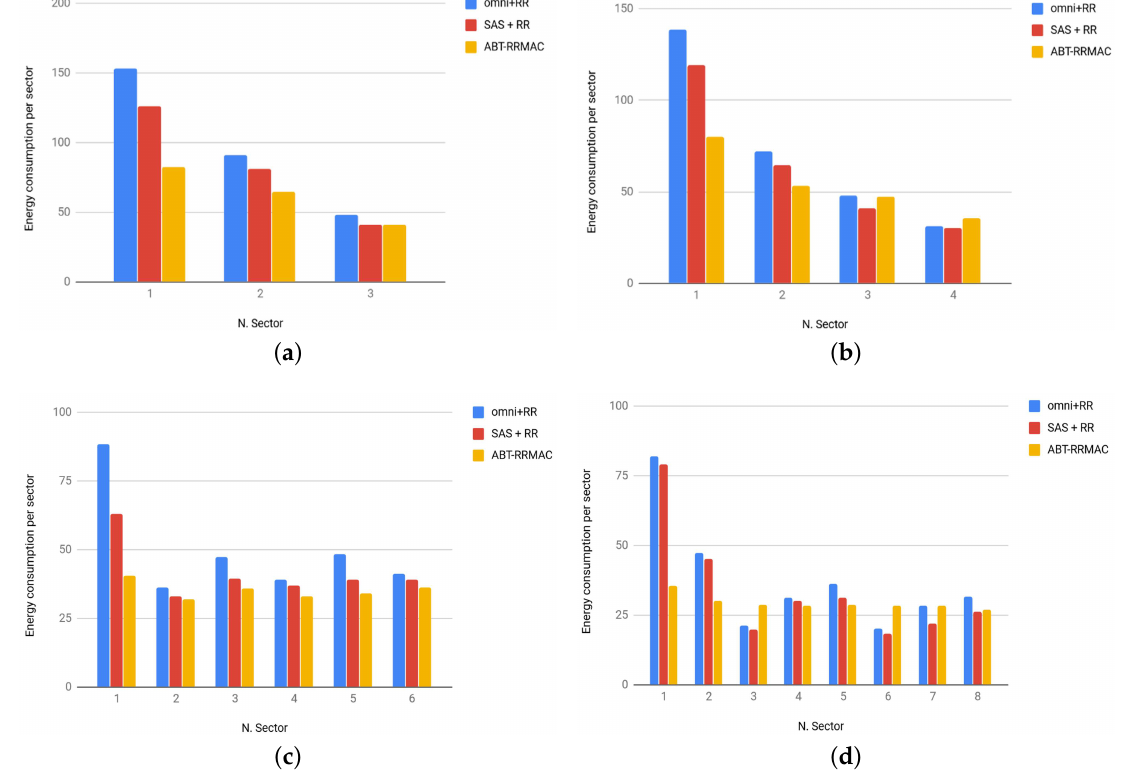
Figure 9. Energy consumption per sectors vs. number of sectors. ( a ) Energy consumption comparison, N s = 3. ( b ) Energy consumption comparison, N s = 4. ( c ) Energy consumption comparison, N s = 6. ( d ) Energy consumption comparison, N s =